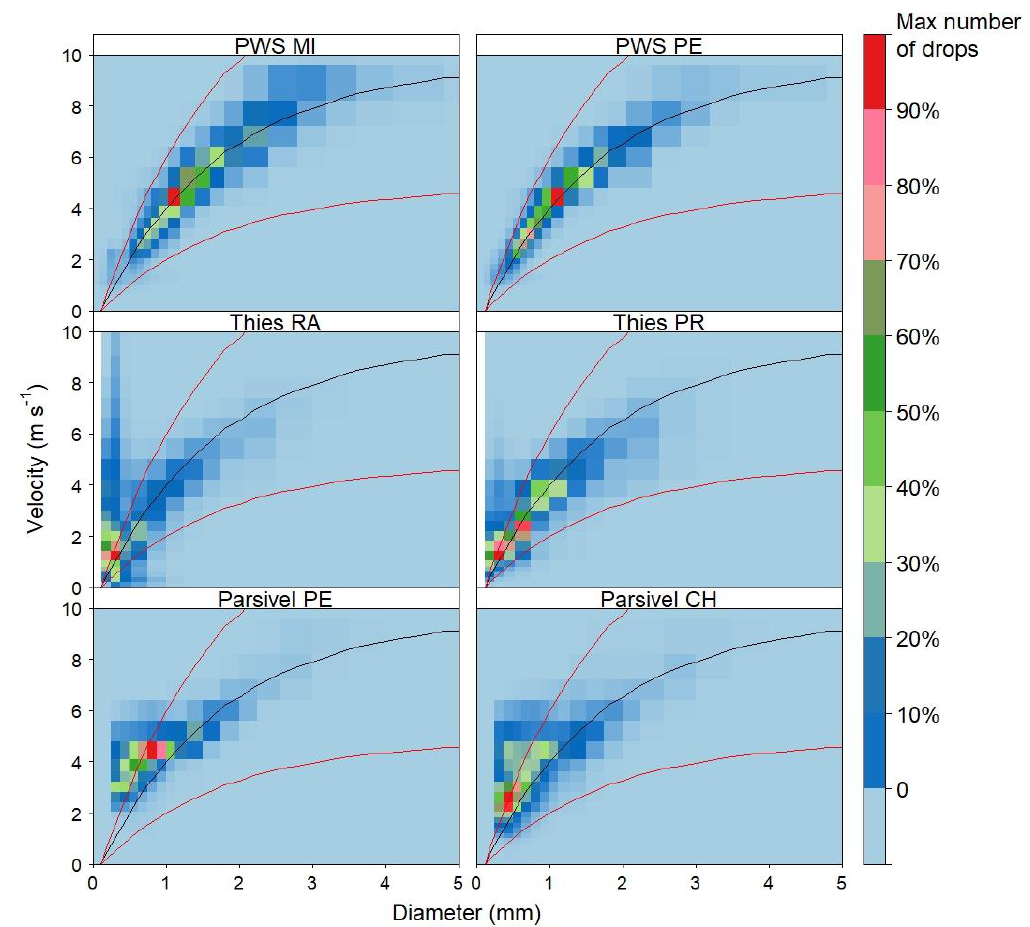
Figure 2. Drop size and velocity distribution for all disdrometers at each site. The color legend describes the percentage of drops in each drop size and velocity class as a percentage of the number of drops in the class with most drops. The black line is the terminal velocity line drawn after Atlas et al. [50]. Drops in classes outside the red lines deviate more than 50% from the terminal velocity line.